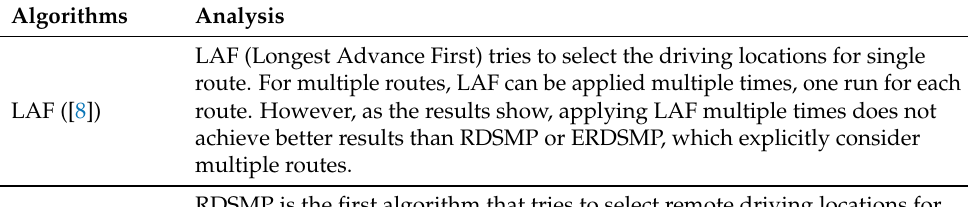
Table 3. Comparative Analysis of